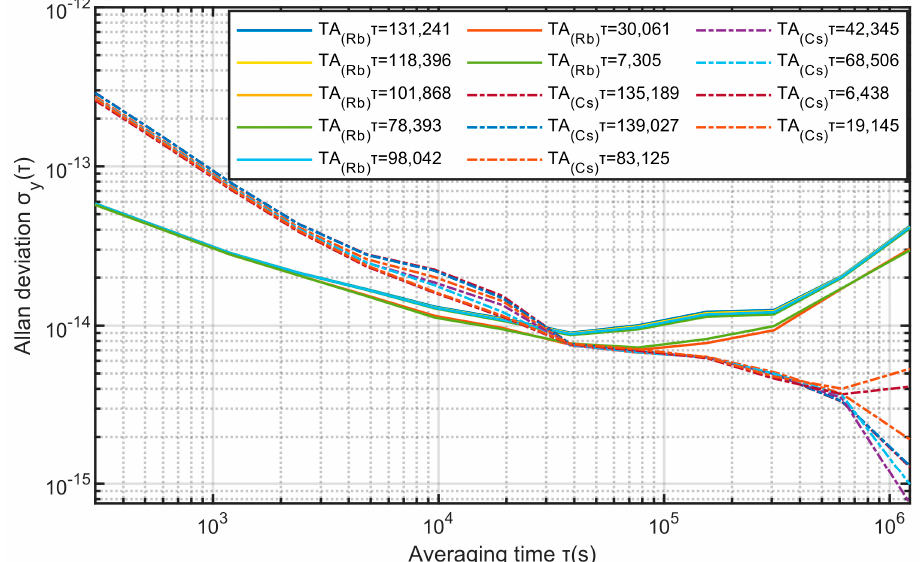
τ . Figure 6. Timescales calculated for different τ